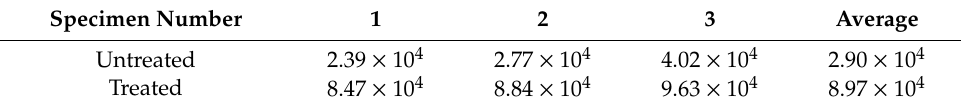
Table 1. Fatigue life of treated and untreated specimens at 400